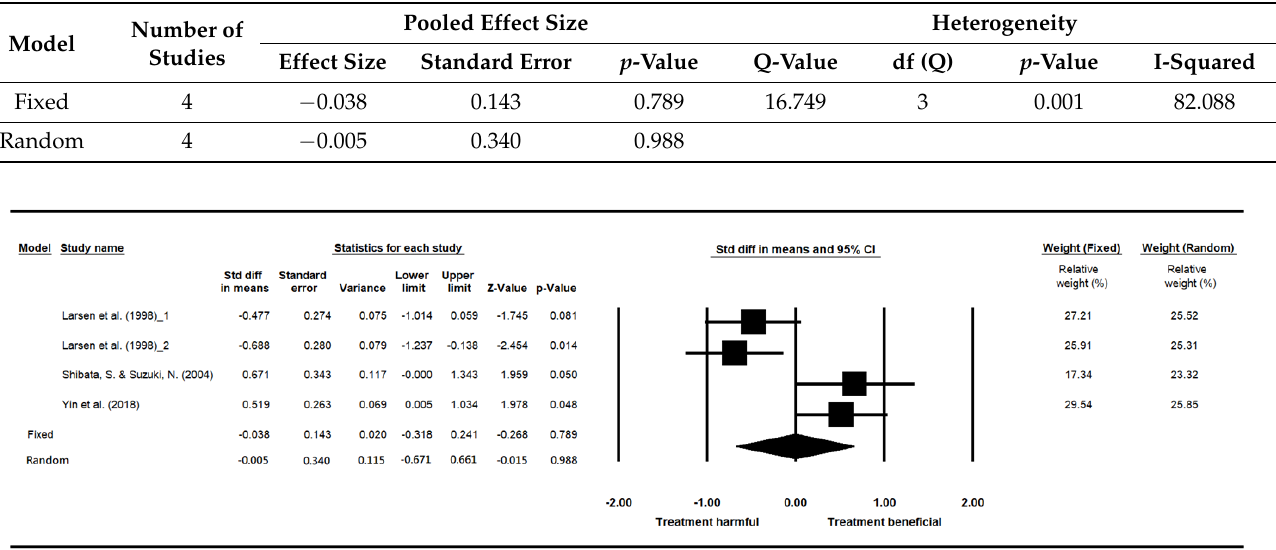
Table 16. Original data of the studies examining the influence of indoor plants on academic achievement.